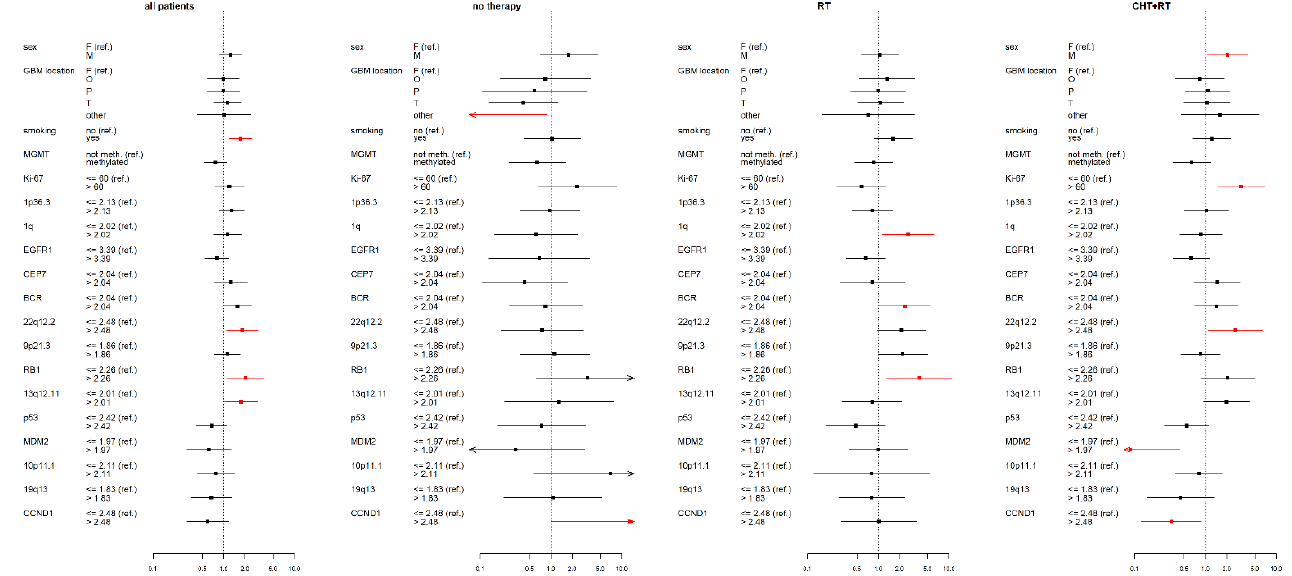
Figure 3. Results of the multivariate Cox proportional hazard models of progression-free survival (PFS) for studied vari- ables (selected clinical factors and molecular markers) in therapy subgroups, expressed using a hazard ratio (a square point — the point estimation, a line segment corresponding to the 95% confidence interval; in case of wider interval than presented scale the arrow is used) for each level of presented factors. The reference category of each factor is labeled with “(ref.)”. Each factor was analyzed in a separate model with adjusting variables— categorized age and Karnofsky score (HRs are not presented). Significant results ( p < 0.05) are shown in red; the dotted line indicates a hazard ratio of 1. RT — radiotherapy; CHT+RT — chemoradiotherapy; F — female; M — male; F — frontal; O — occipital; P — parietal; T — temporal;